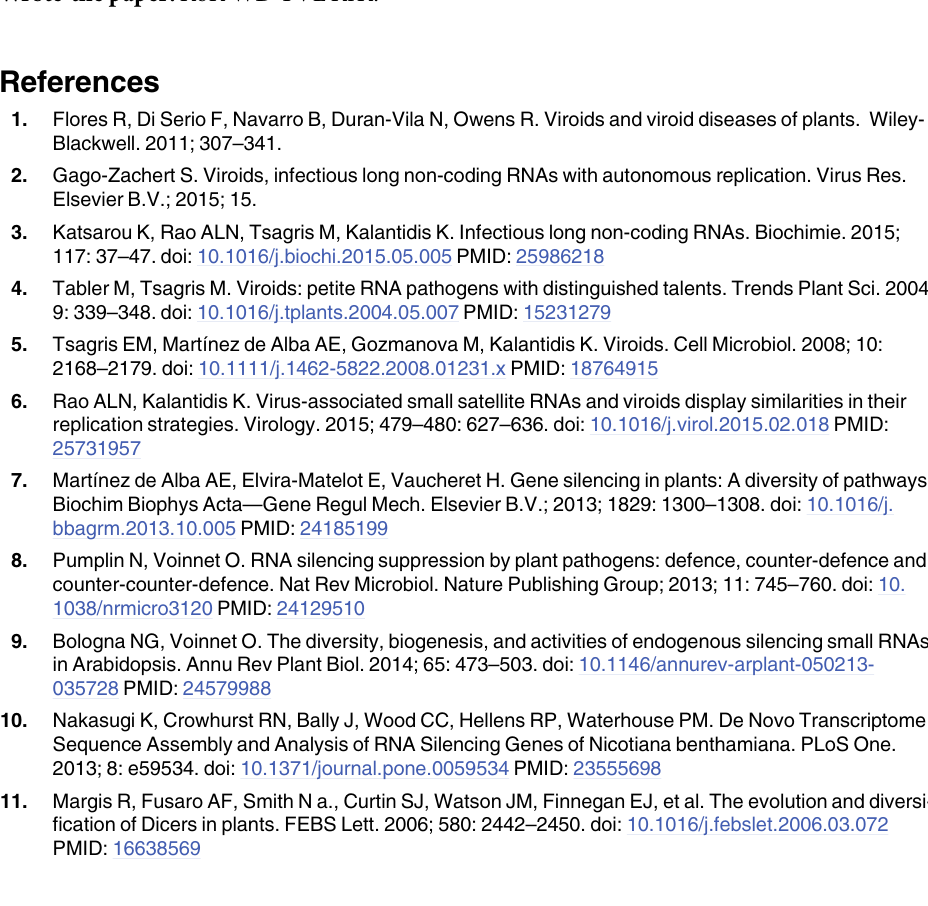
S5 Table. Accession IDs of N . benthamiana transcripts used for measurement of intra- array